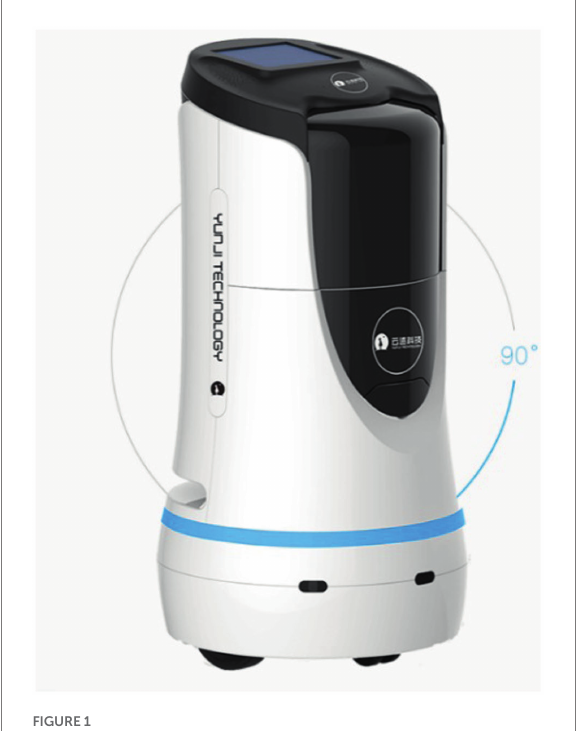
FIGURE 1 Intelligent delivery robot run. Source: https://www.yunjichina. com.cn/product_run.html. Reproduced with